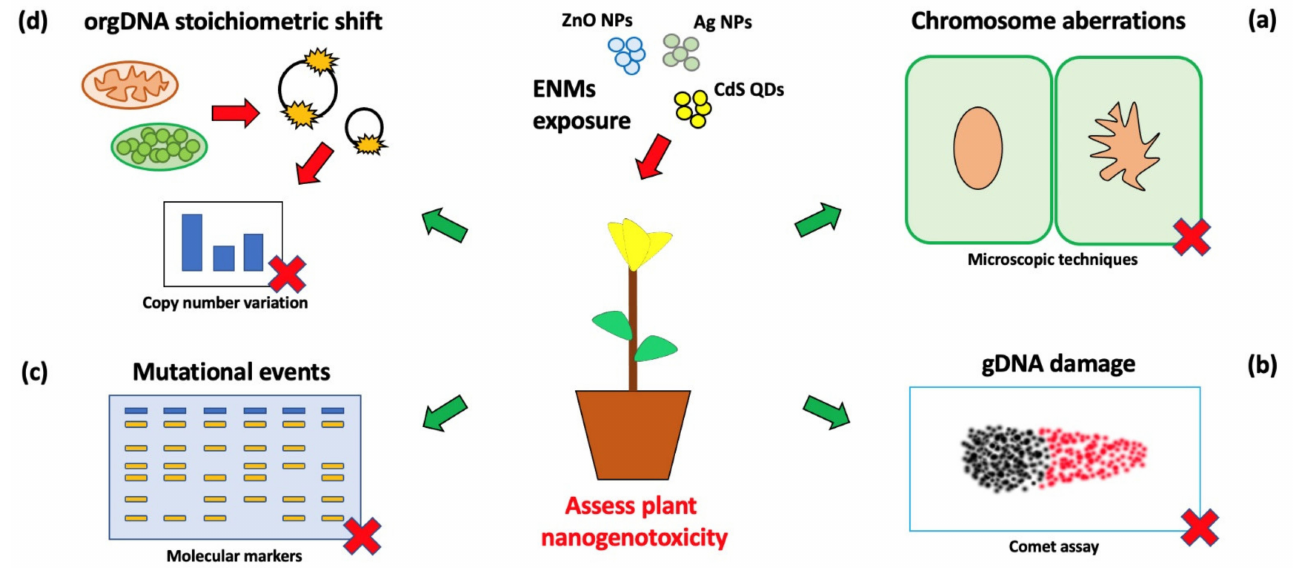
Figure 1. Schematic representation of the methodologies utilized to highlight plant ENM genotox- icity: ( a ) microscopic techniques to highlight chromosomal aberrations, ( b ) electrophoresis-based methods (e.g., comet assay) to highlight genomic DNA (gDNA) damage, ( c ) molecular markers (e.g., RAPD) to show mutational events and ( d ) Real time PCR based methods to highlight copy number variation (stoichiometric or sub-stoichiometric shift) in plastid (ptDNA) or mitochondrial (mtDNA) genomes. These techniques can be utilized as Alternative Testing Strategies (ATS), in assessing and/or characterizing the risk associated with ENMs exposure/effects, not only in experimental controlled conditions, but also in monitoring of realistic scenarios, at early exposure